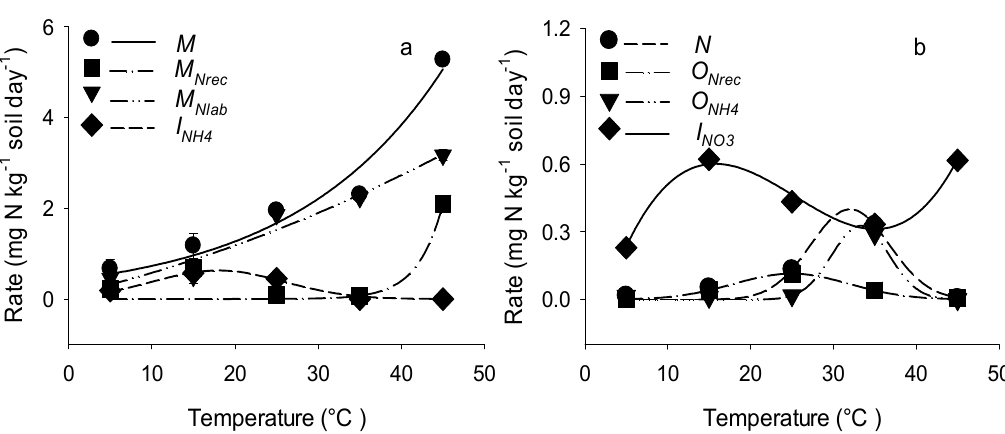
Figure 3. Non-linear trends in the gross rates of soil N transformation processes as a function of imposed incubation temperatures. Vertical bars indicate standard deviations of the mean value. ( a ) M ( M Nrec + M Nlab ), gross rates of total N mineralization; M Nrec , mineralization rate of recalcitrant organic N pool to NH 4 + ; M Nlab , mineralization of labile organic N pool to NH 4 + ; I NH4 , gross rates of NH 4 + immobilization; ( b ) N ( O Nrec + O NH4 ), gross rates of nitrification; O Nrec , oxidation rate of recalcitrant organic N to NO 3 − (heterotrophic nitrification rate); O NH4 , oxidation rate of NH 4 + to NO 3 −